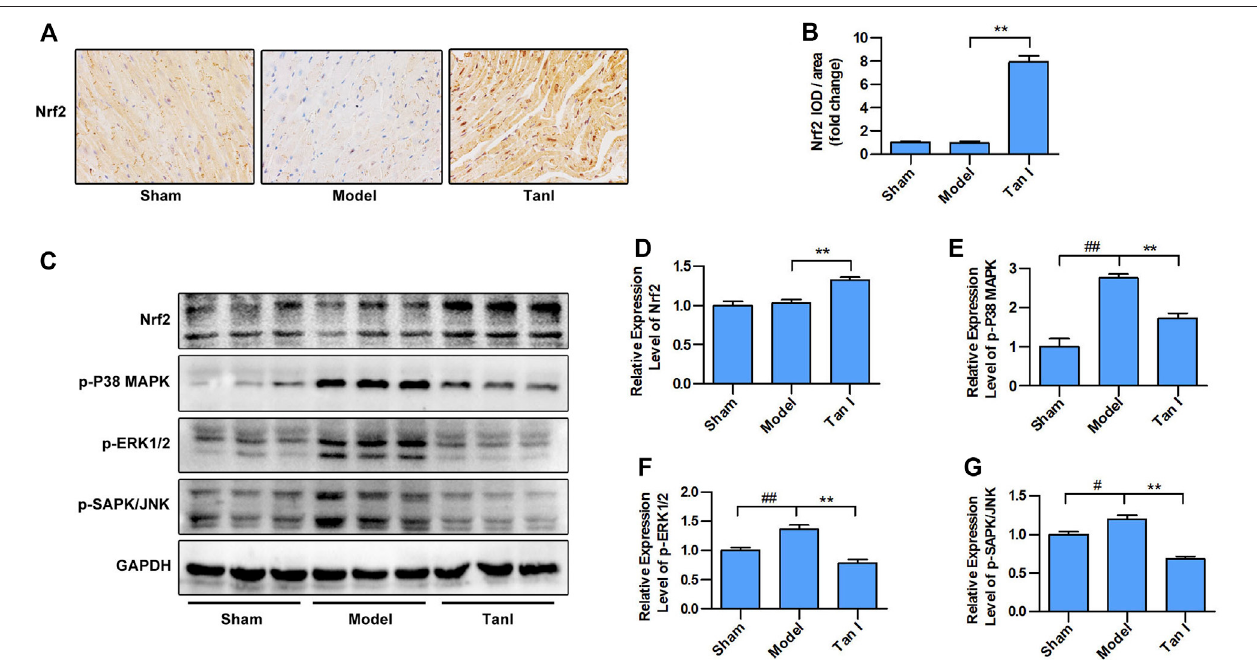
FIGURE 6 | Tan I inhibits isoproterenol-induced myocardial injury by regulating Nrf2/MAPK signaling. (A) Immunohistochemistry (IHC) analysis. (B) Relative expression of Nrf2. (C) Expression levels of Nrf2 and MAPK signaling, including p-P38 MAPK, p-ERK1/2, and p-SAPK/JNK measured using Western blotting analysis. (D) RelativeexpressionlevelsofNrf2. (E) Relativeexpressionlevelsofp-P38MAPK. (F) Relativeexpressionlevelsofp-ERK1/2. (G) Relativeexpressionlevelsofp-SAPK/ JNK. Data are presented as mean ± S.D. # p < 0.05, ## p < 0.01, compared to the sham group. *p < 0.05, **p < 0.01, compared to the model group ( n (cid:2)